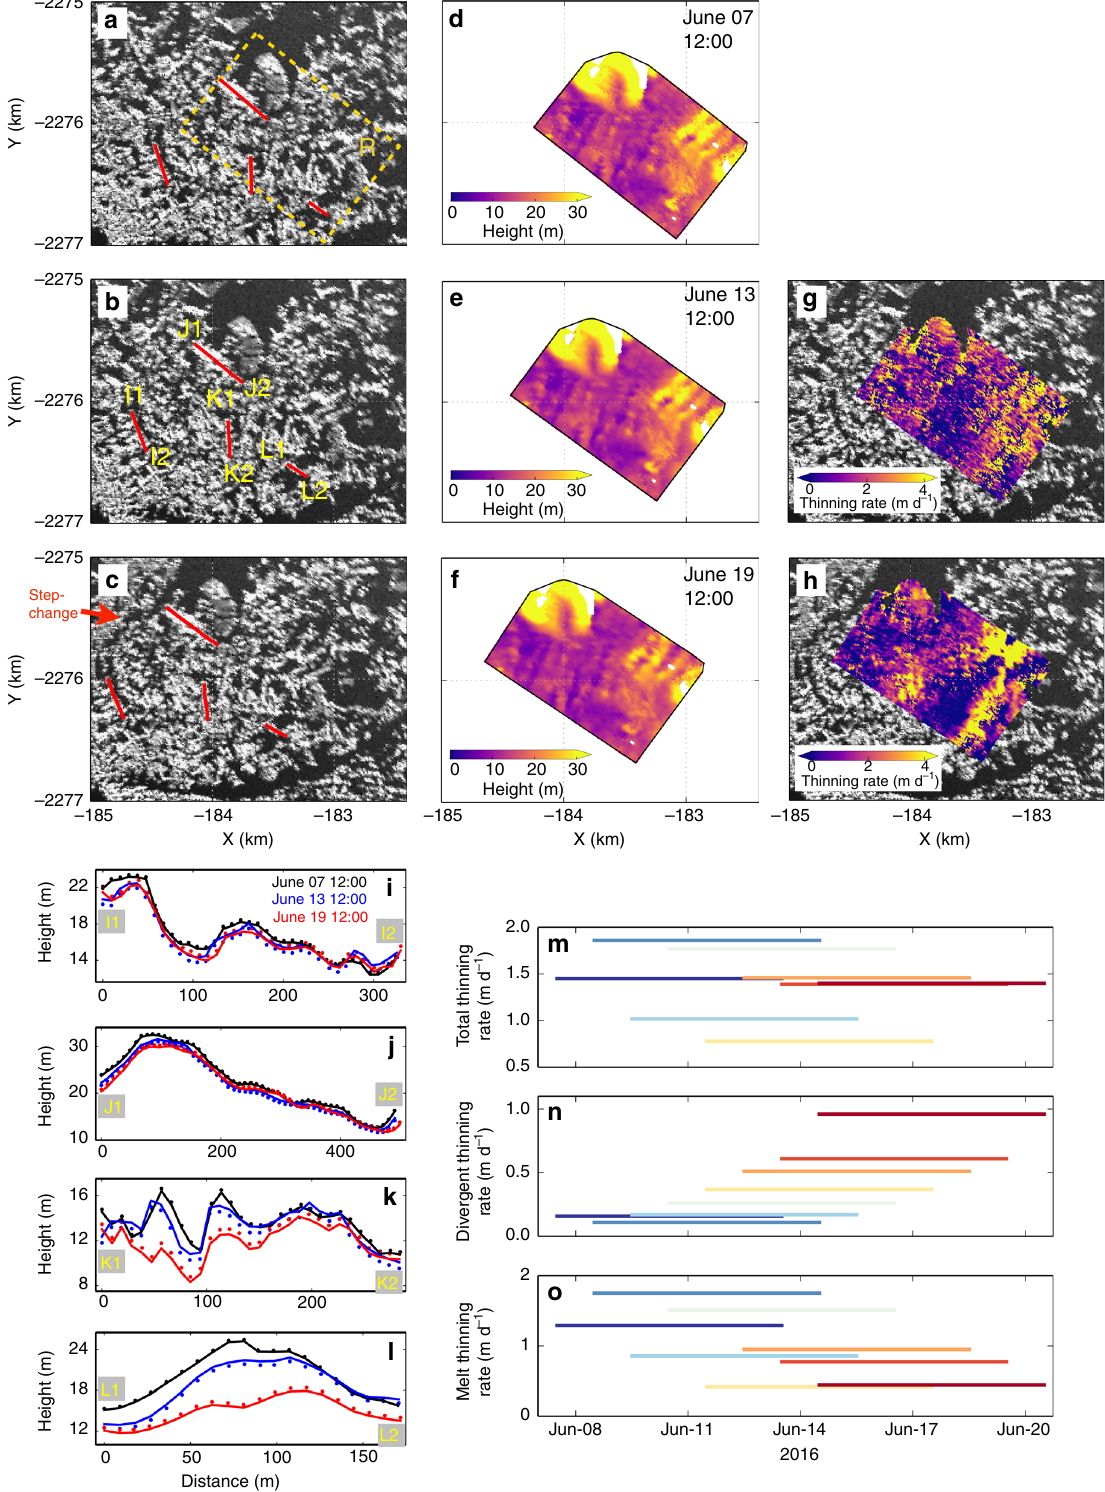
Fig. 5 Mélange thinning. a – c TRI amplitude images, corresponding to times shown in d – f . In a , dashed rectangle R outlines an initial box used to estimate mélange thinning, convex hulls of the evolving box are shown in d – f ; red lines are selected pro fi les to show examples of mélange thinning in i – l , their evolving shapes and locations are shown in b and c . d – f Tidal height subtracted surface elevation of mélange within the selected box, shapes and locations in e and f are estimated based on feature tracking. g Thinning rate from d to e . h Thinning rate from e to f . i – l Surface elevation pro fi les corresponding to I1 – I2, J1 – J2, K1 – K2, and L1 – L2 labeled in b . Black, blue, and red lines correspond to times labeled in i . Dots show observed elevations, lines have tidal height subtracted. Due to >30 m d − 1 moving speed of ice in the study area, an Eulerian reference frame is not suitable for mélange thinning estimate, therefore a Lagrangian reference frame is used. m – o Inferred mean thinning rates from measurements separated by 6 days, color from dark blue to dark red corresponding to the fi rst and last image